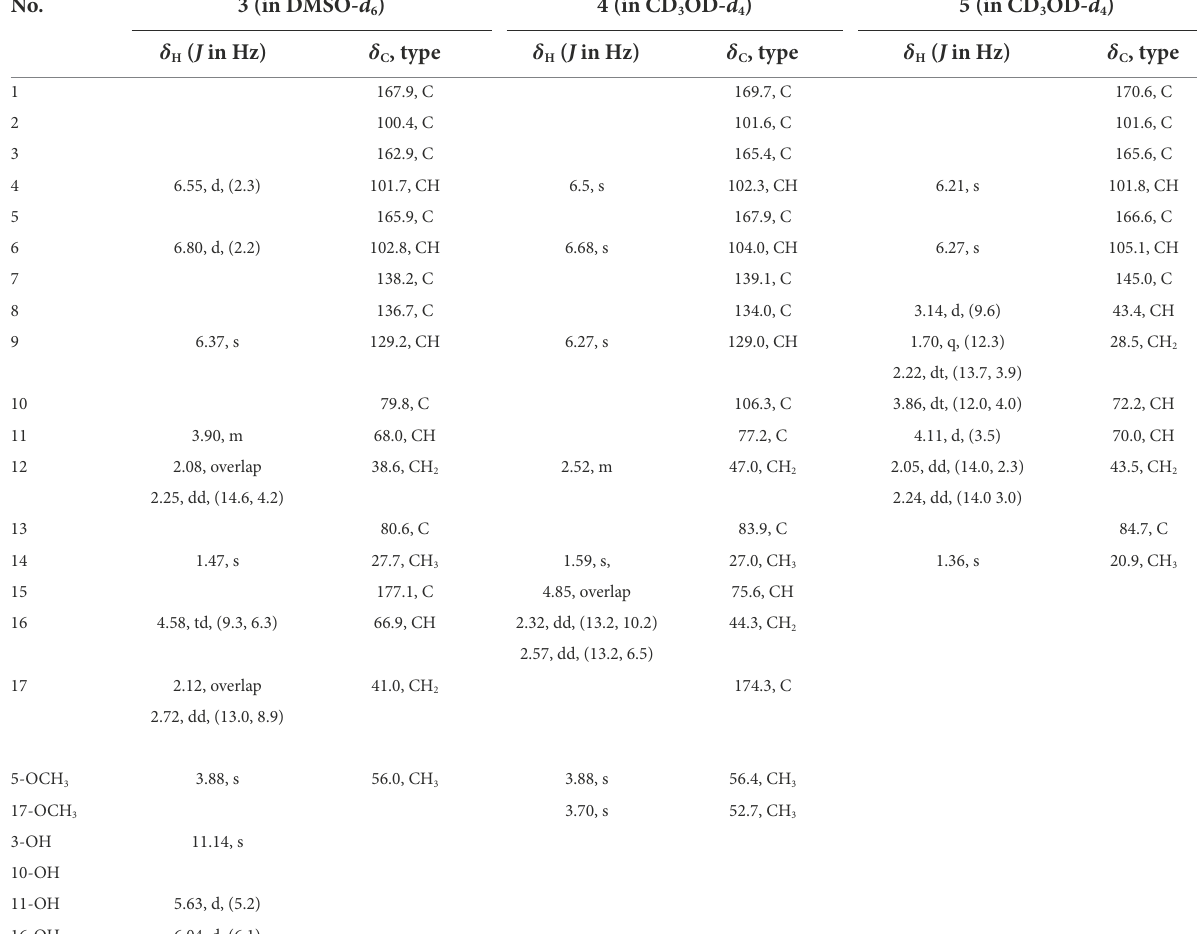
TABLE 2 1 H (600 MHz) and 13 C NMR (150 MHz) data of compounds (3–5).